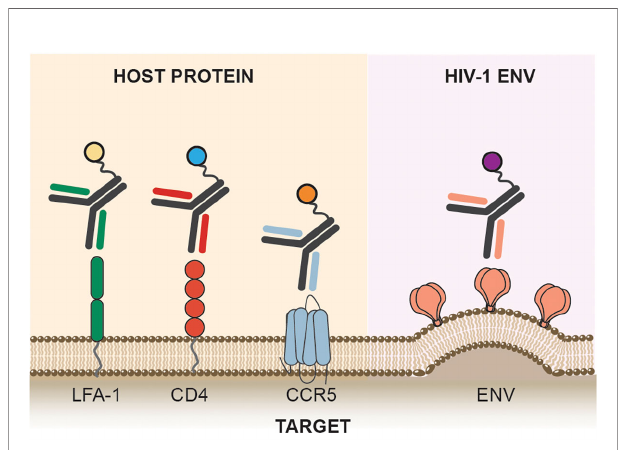
FIGURE 2 | Targets. Antibody conjugates can target host receptors required for viral entry, CD4, and coreceptor such as CCR5. Host factors such as LFA-1, an integrin protein expressed on lymphocytes are also targeted by antibody conjugates. HIV-1 Env, the sole viral protein expressed on infected cells is also the targets of antibody